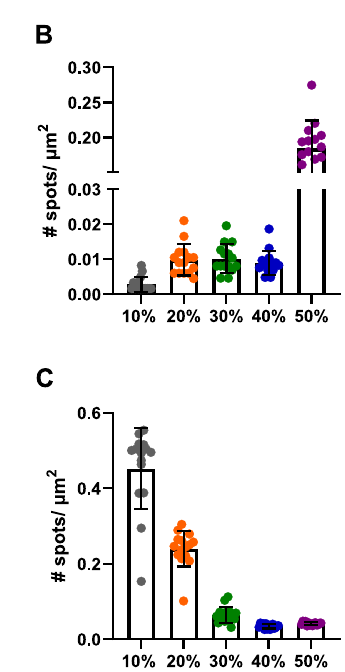
Fig. 5 | Different α -synuclein species are present in different sucrose fractions. A Principle of the single-molecule pulldown (SiMPull) assay using the same pair of antibodies (abbreviated as ab in the schematic), including representative TIRF images for the 50% fraction using the MJF and SC antibodies. The biotinylated captureantibody(abbreviatedasabintheschematic)isattachedtothepassivated surface via a biotin (orange) neutravidin linkage (grey). The capture antibody can pulldown its distinct antigen. The captured aggregates are sandwiched by primary monoclonal fl uorescently labelled (red star) detection antibody. Scale bar=5 µ m. The images are contrast adjusted. The schematic has been created with BioR- ender.com. B Number of detected species in each sucrose fraction using the conformation-speci fi c MJFantibodytargeting aggregated fi lamentous α -synuclein.